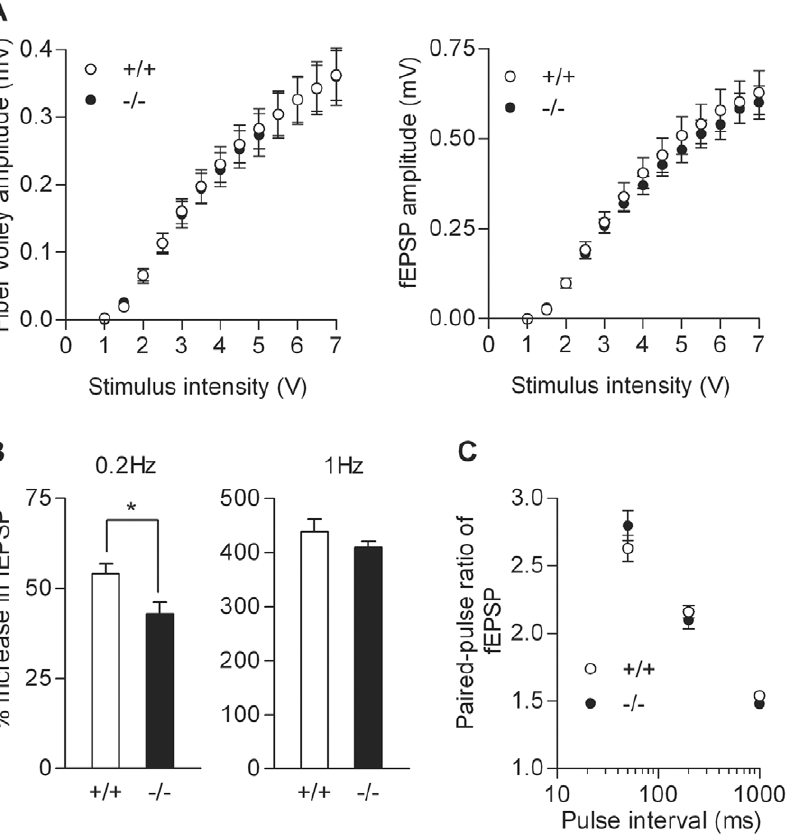
Figure 2. Basic properties of synaptic transmission at mossy fiber synapse. (A) Input-output relationship at the mossy fiber-CA3 synapse. The amplitude of the presynaptic fiber volley (left) and fEPSP (right) was plotted against the stimulus intensity (n=15 slices each). (B) Frequency facilitation induced by repetitive stimulation was reduced in mutant mice at the stimulus frequency of 0.2 Hz ( + / + : 54.0 6 2.8% increase, n=8; 2 / 2 : 42.9 6 3.3% increase, n=11; p =0.039), but not at 1 Hz ( + / + : n=7; 2 / 2 : n=10). (C) No significant difference in facilitation of fEPSP induced by paired stimulation ( + / + : n=8; 2 / 2 : n=9).